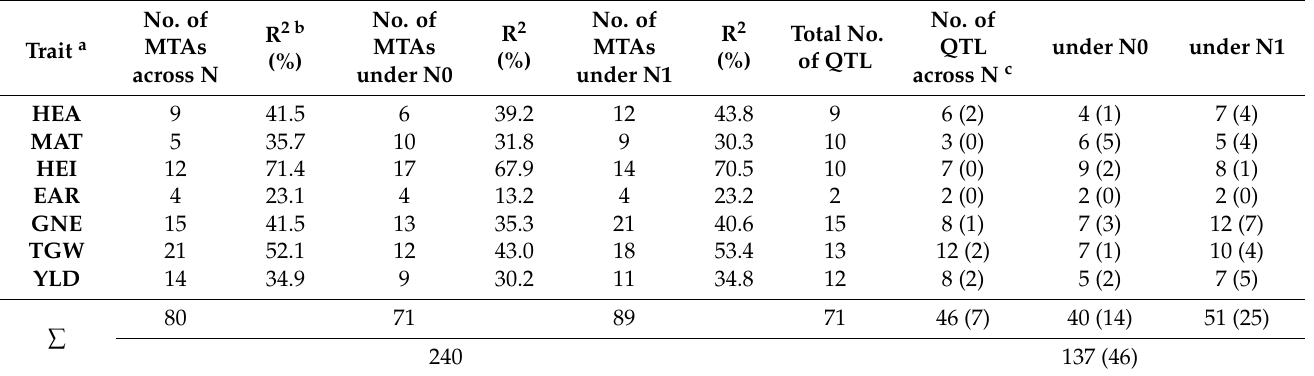
Table 3. The number of significant marker-trait-associations (MTA) with BON_ p < 0.05 and QTL per trait, given across N treatments and per treatment (N0 and